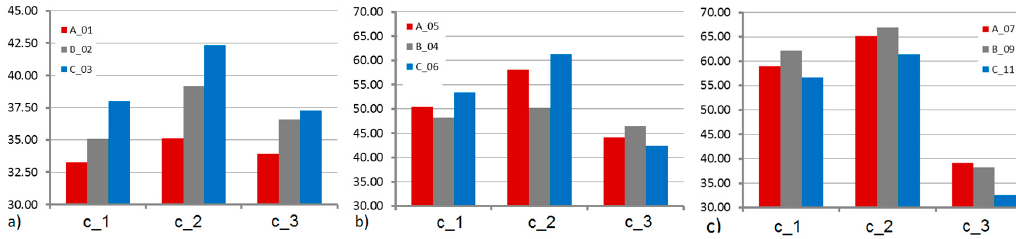
Figure 7. Averaged temperature values; ( a ) Temperature of absorber surface (°C); ( b ) Temperature behind gypsum board representing heat accumulation layer (°C); ( c ) air cavity temperatures (°C).